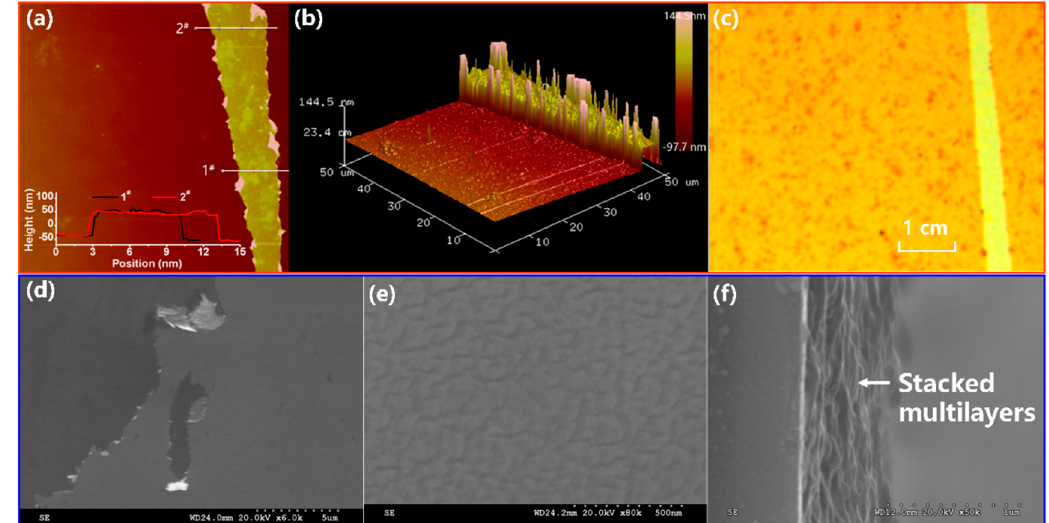
Figure 5. AFM images ( a , b ), optical micrograph image ( c ), and SEM images ( d – f ) of the (PAH/rGO − PSS) 100 (PEI/PSS) 2 film.